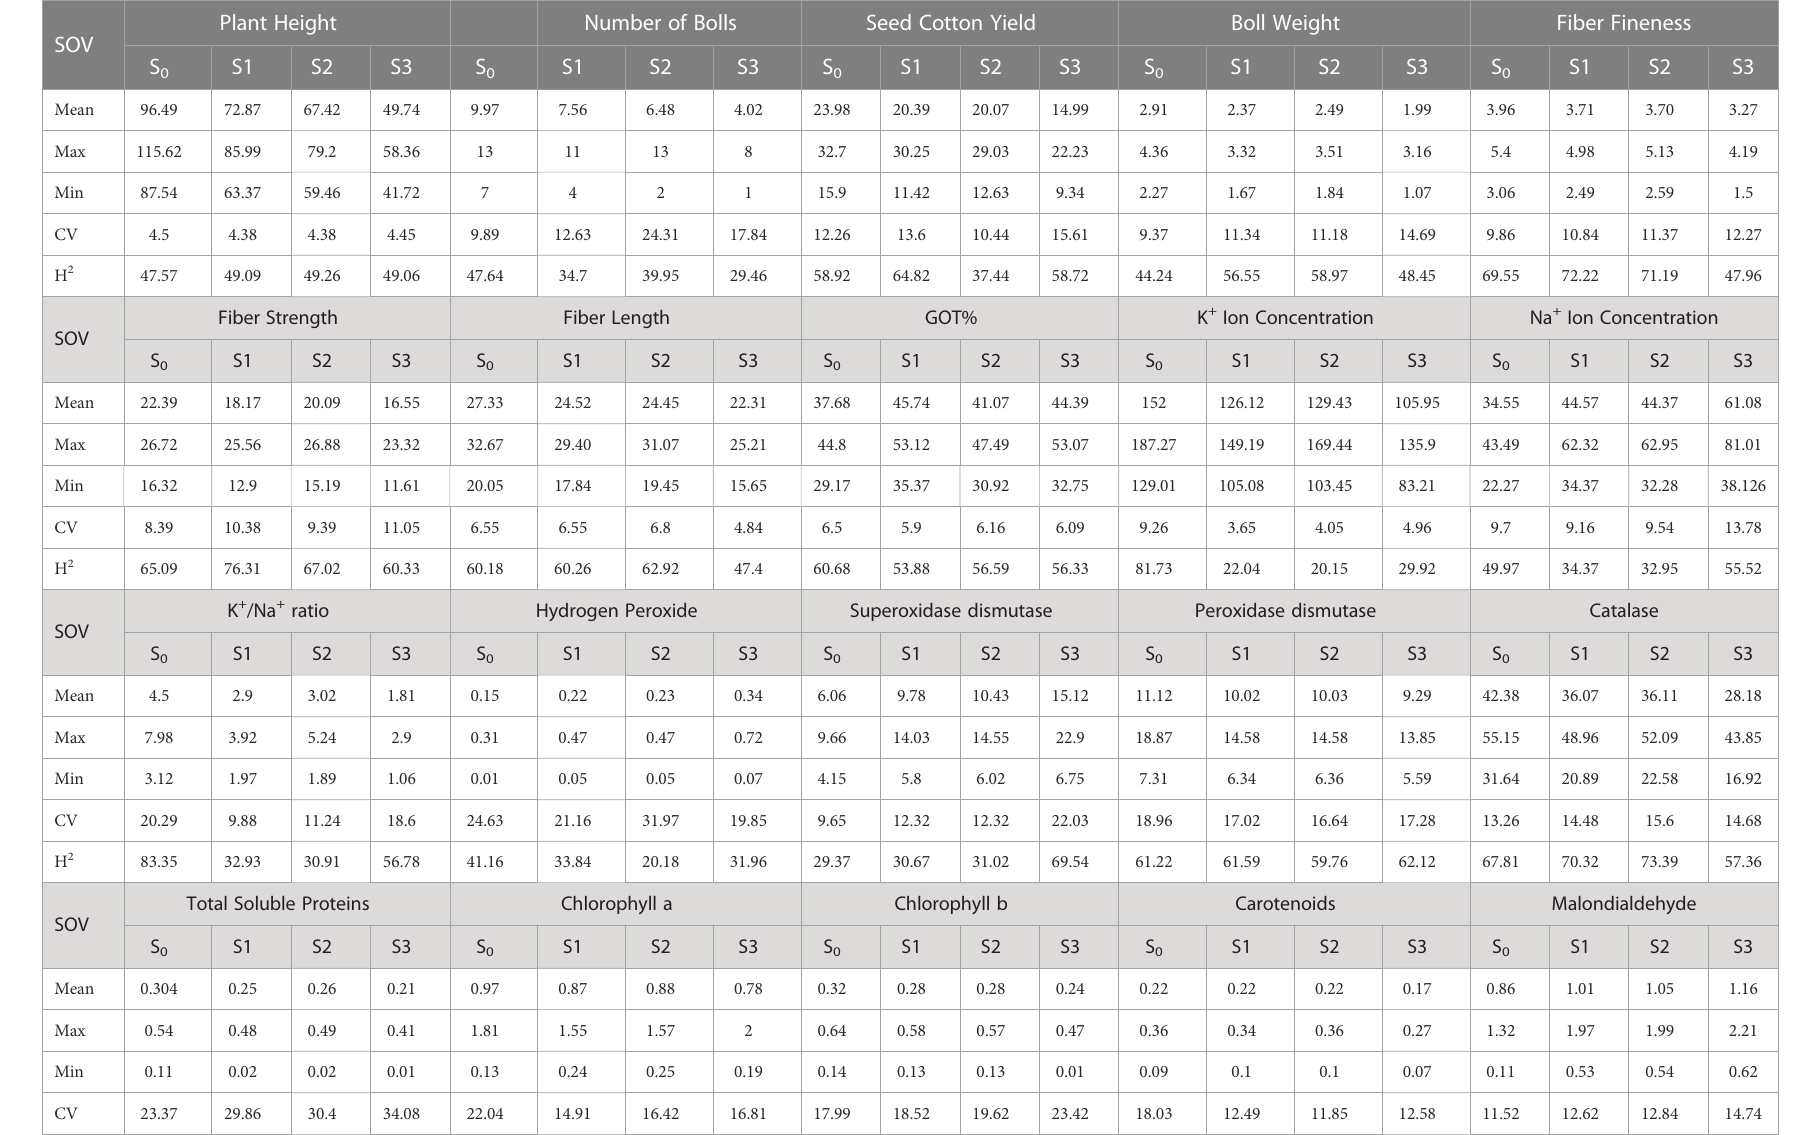
TABLE 4 Second year components of variability and heritability of various traits under control and stress conditions. Plant Height Number of Bolls Seed Cotton Yield Boll SOV